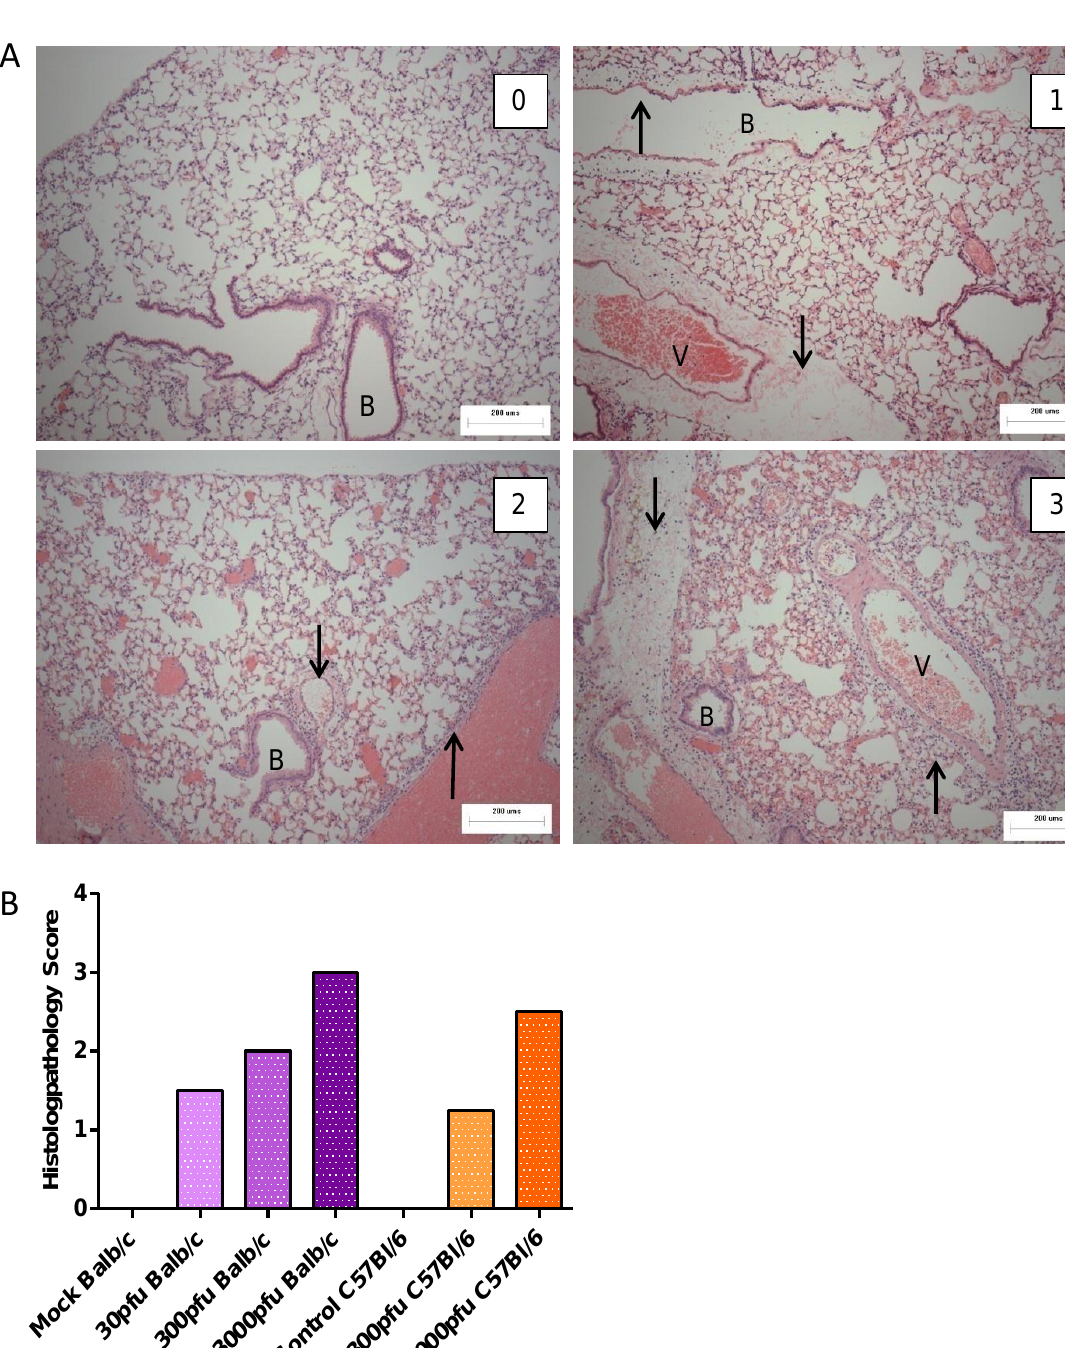
Figure 2. Histopathological analysis of PVM-infected mice. Five to six week-old Balb/c and C57Bl/6 mice were inoculated with medium, 30 pfu, 300 pfu, or 3000 pfu of PVM 15 and lungs were collected from four mice on day 6 p.i. for histopathological analysis. In ( A ), representative lung sections for animals scoring 0 , 1 , 2 , and 3 are shown, with the upward arrows (↑) indicating infiltrating inflammatory cells and the downward arrows (↓) indicating oedema in the tissue. The bronchiole is labeled with the letter B and the blood vessel with V. Scores were given on the basis of the severity and dissemination of the lesions visible in duplicate lung sections, and median values are shown for each group ( B